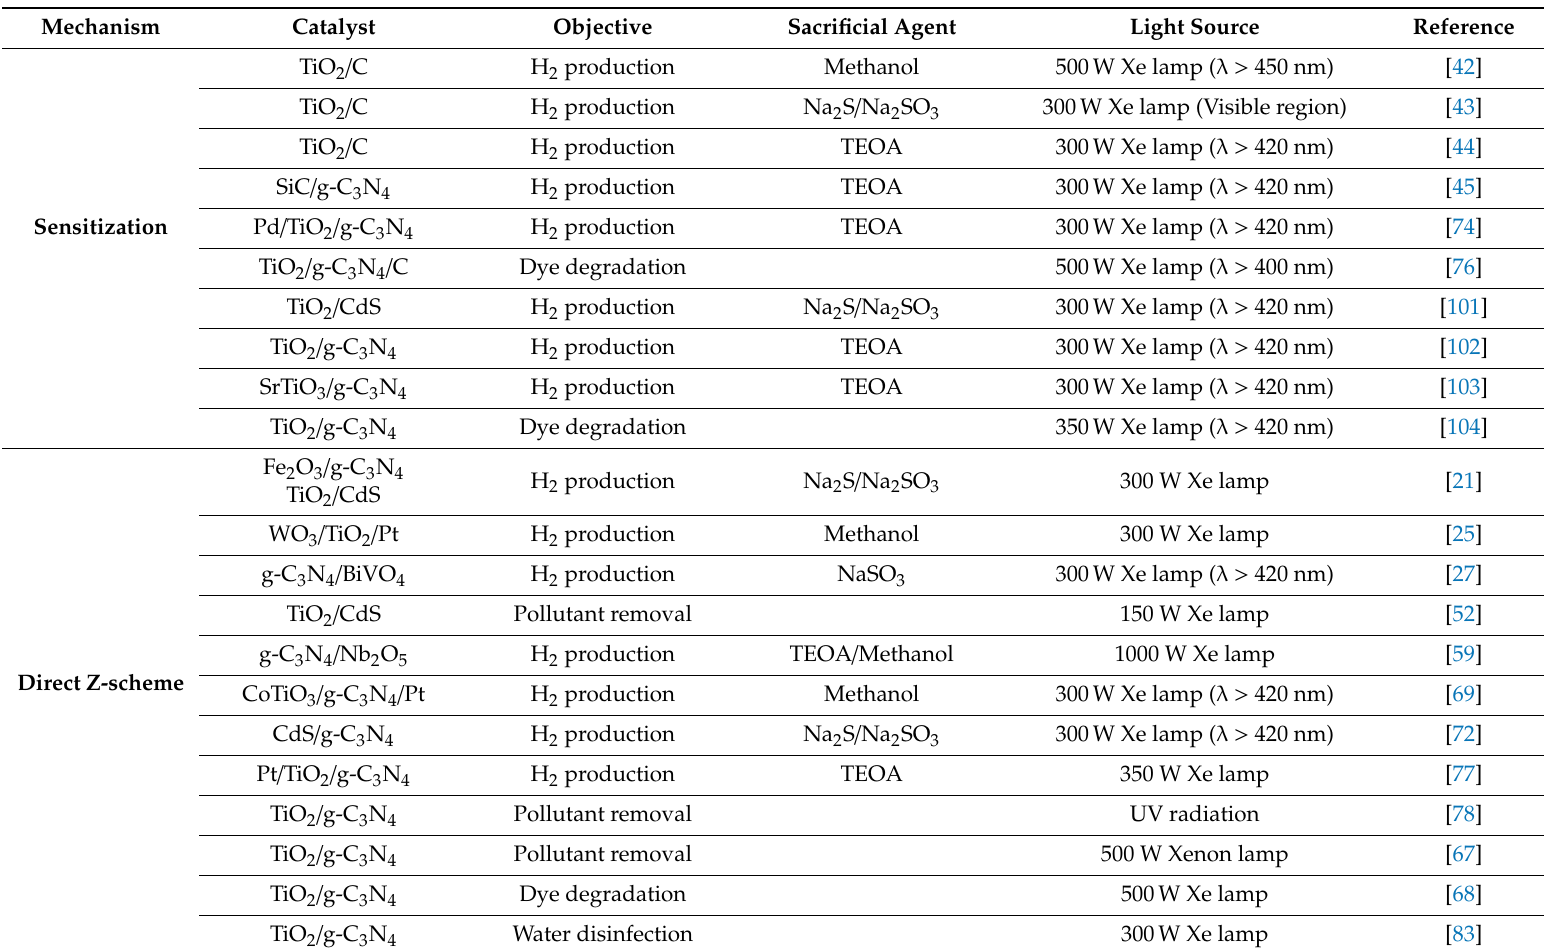
Table 2. Charge transfer mechanism reported for di ff erent hybrid